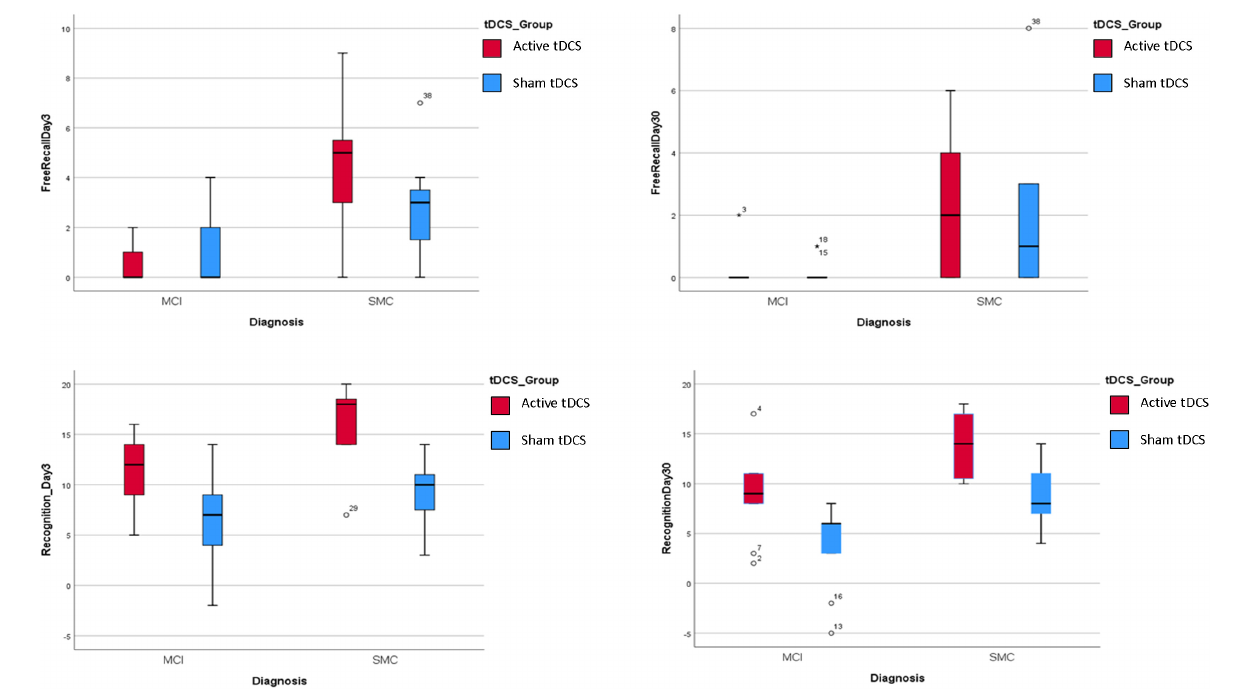
FIGURE 4 | Association between diagnosis and the four response variables by tDCS group. For all the response variables, in the Active treatment the scores for all the 4 response variables were higher than in the sham treatment irrespectively for Diagnosis